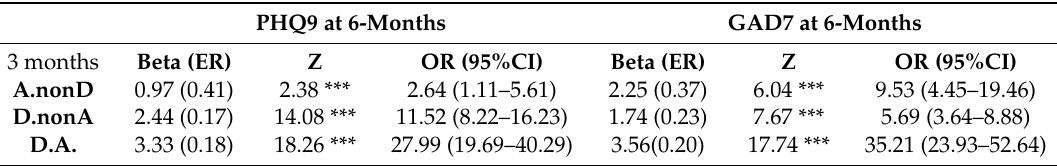
Table A3. Depression and anxiety groups at three months predicting depression and anxiety (cut-o ff point of 8) at six months using logistic regression.